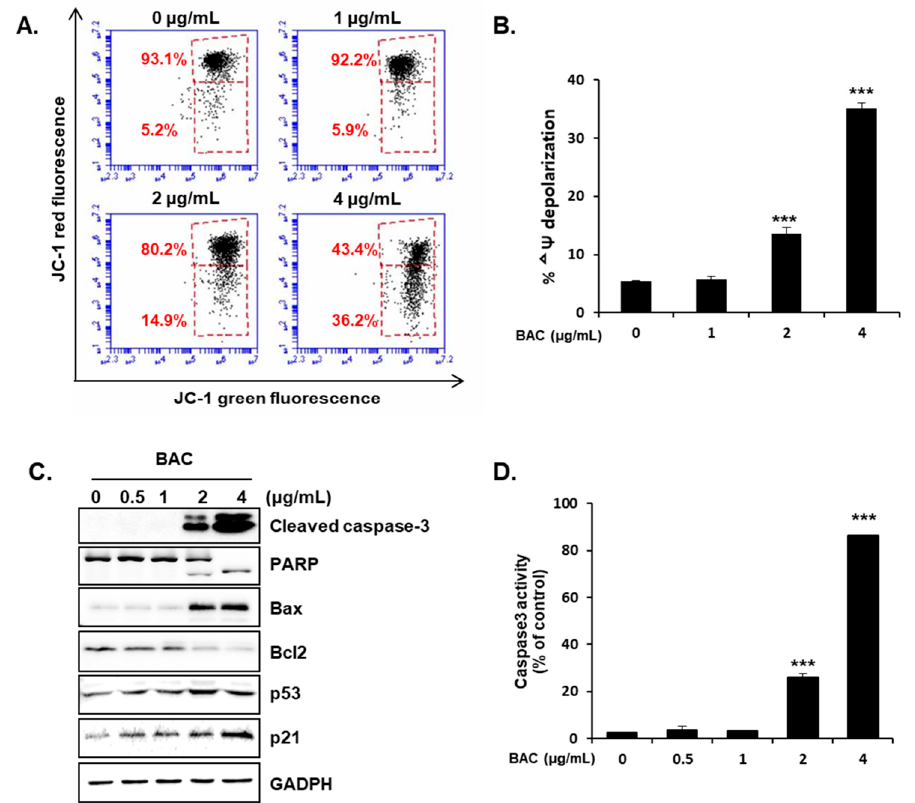
Figure 3. BAC-induced mitochondrial dysfunction and activation of apoptosis-related pathways in H358 cells. Cells were treated with BAC for 24 h. ( A ) Changes in mitochondrial membrane potential as observed by JC-1 staining, using fluorescence-activated cell sorting (FACS) analysis and ( B ) quantification of three independent experiments. ( C ) Protein expression of caspase-3, PARP, Bax, Bcl2, p53, and p21. GAPDH is used as a loading control. ( D ) Caspase-3 activity in H358 cells after BAC treatment for 24 h. The results are presented as the mean ± SD of triplicate experiments. Statistical significance was determined by Student’s t-test (*** p < 0.001 compared to untreated cells).